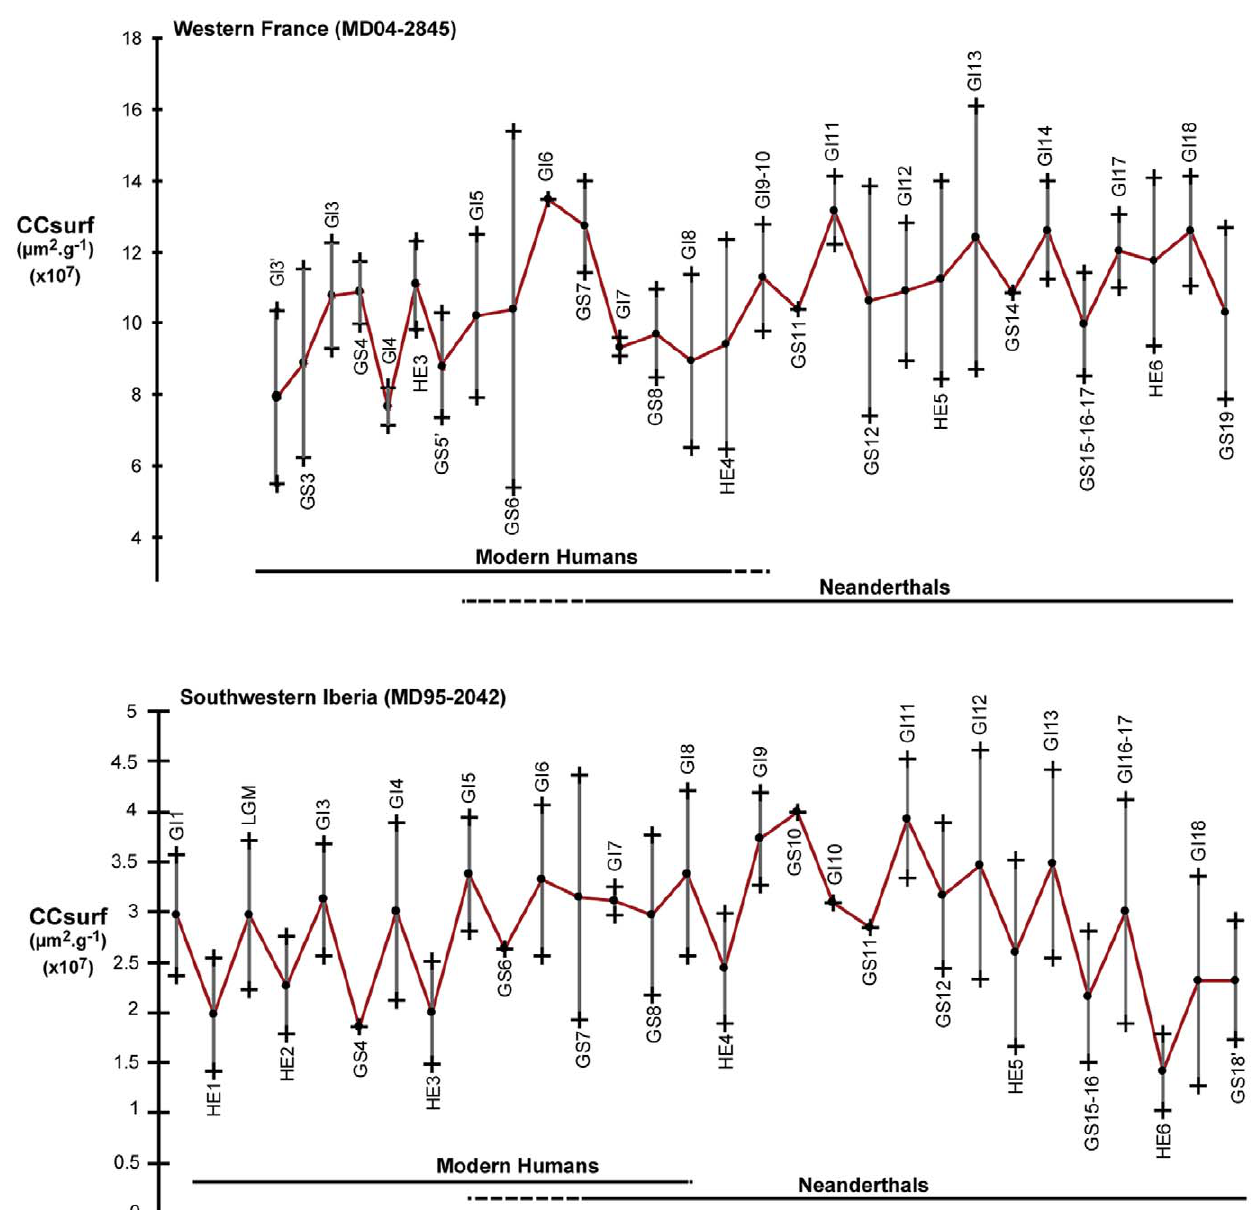
Figure 4. Evolution of average surface area of microcharcoal (CCsurf) with standard deviation reported for each Greenland Stadial (GS), including Heinrich Stadials (HSs), and Greenland Interstadial (GI) in core MD04-2845 and MD95-2042 compared to the chronological extent of Neanderthals and Modern humans.